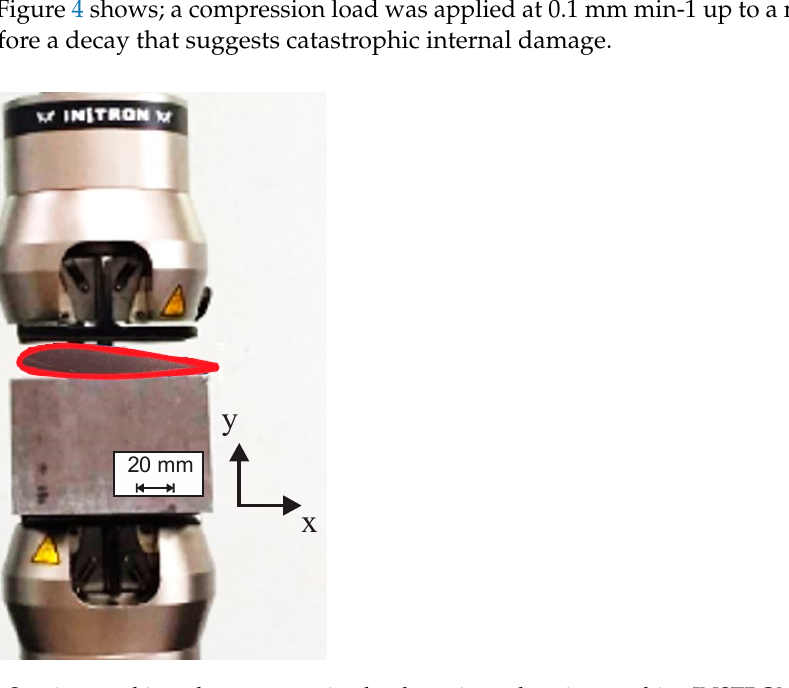
Figure 3. Examples of different simples manufactured for this work: ( a ) NACA 633618, CF-PLA; ( b ) NACA 23015, CF-PLA; 1—solid (control); 2—P_Hole; 3—D_Hole.